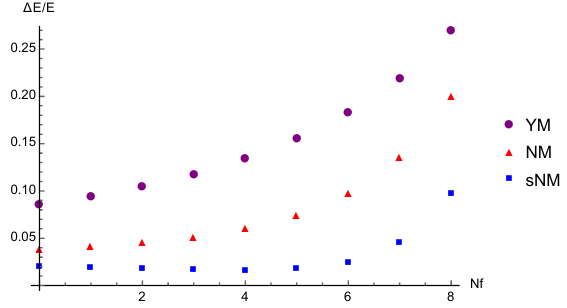
’s from (5.1), (5.2) at the scale t = 0 . 008 / Λ 2 i